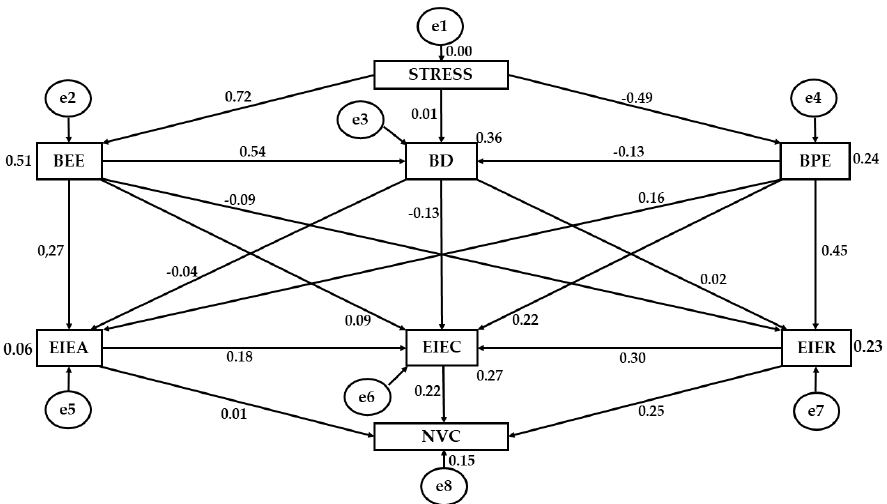
Figure 2. Structural equation model. Note: BEE, emotional exhaustion; BD, depersonalization/cynicism; BPE, personal efficacy; EIEA, emotional attention; EIEC, emotional larity; EIER, emotional repair; NVC, non-verbal communication.